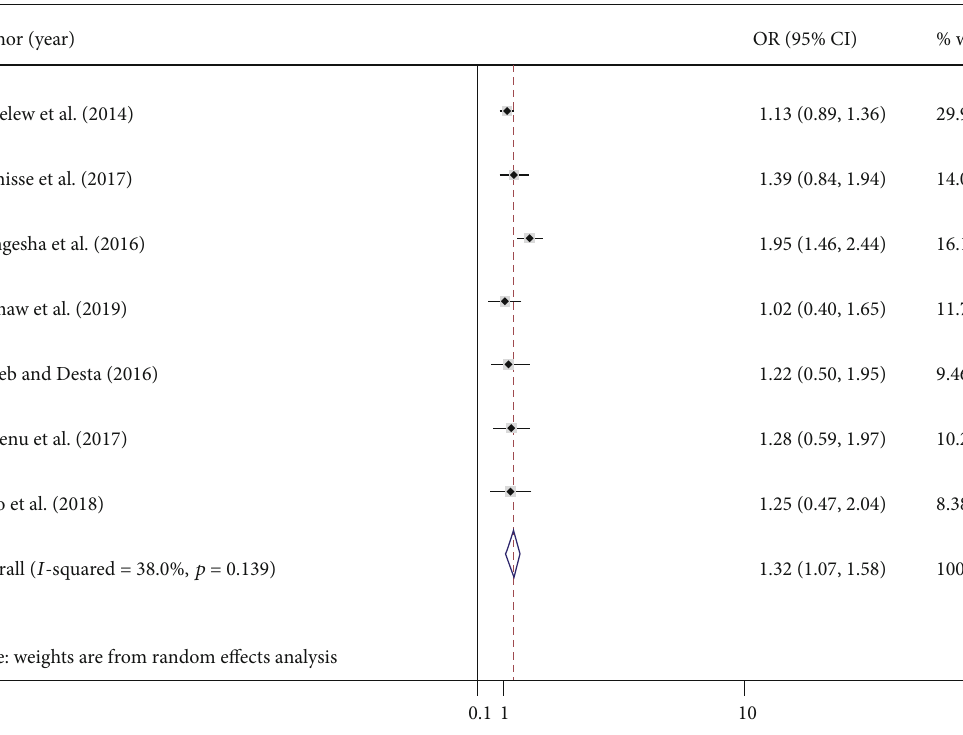
Figure 4: The pooled odds ratio of the association between GA and neonatal mortality.